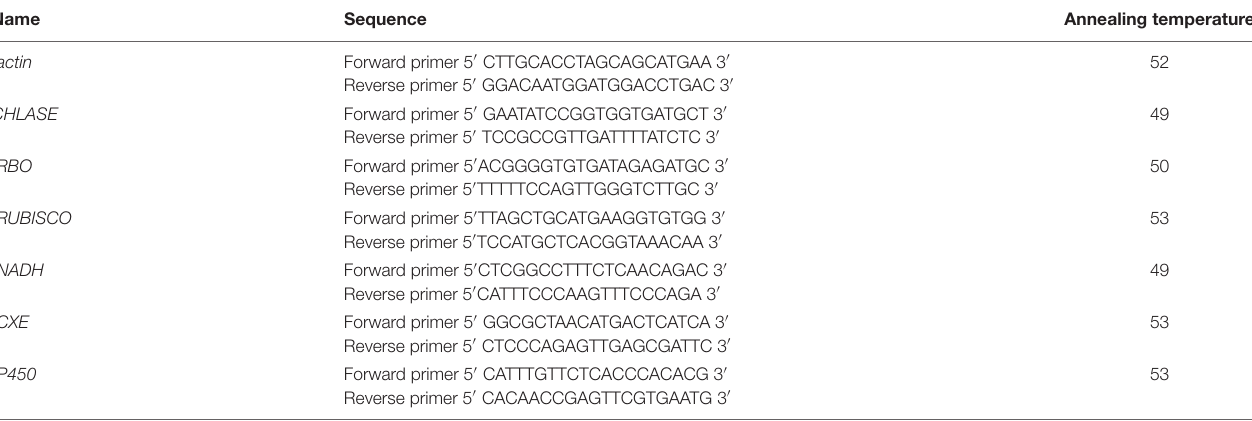
TABLE 1 | Primers used in relative gene expression